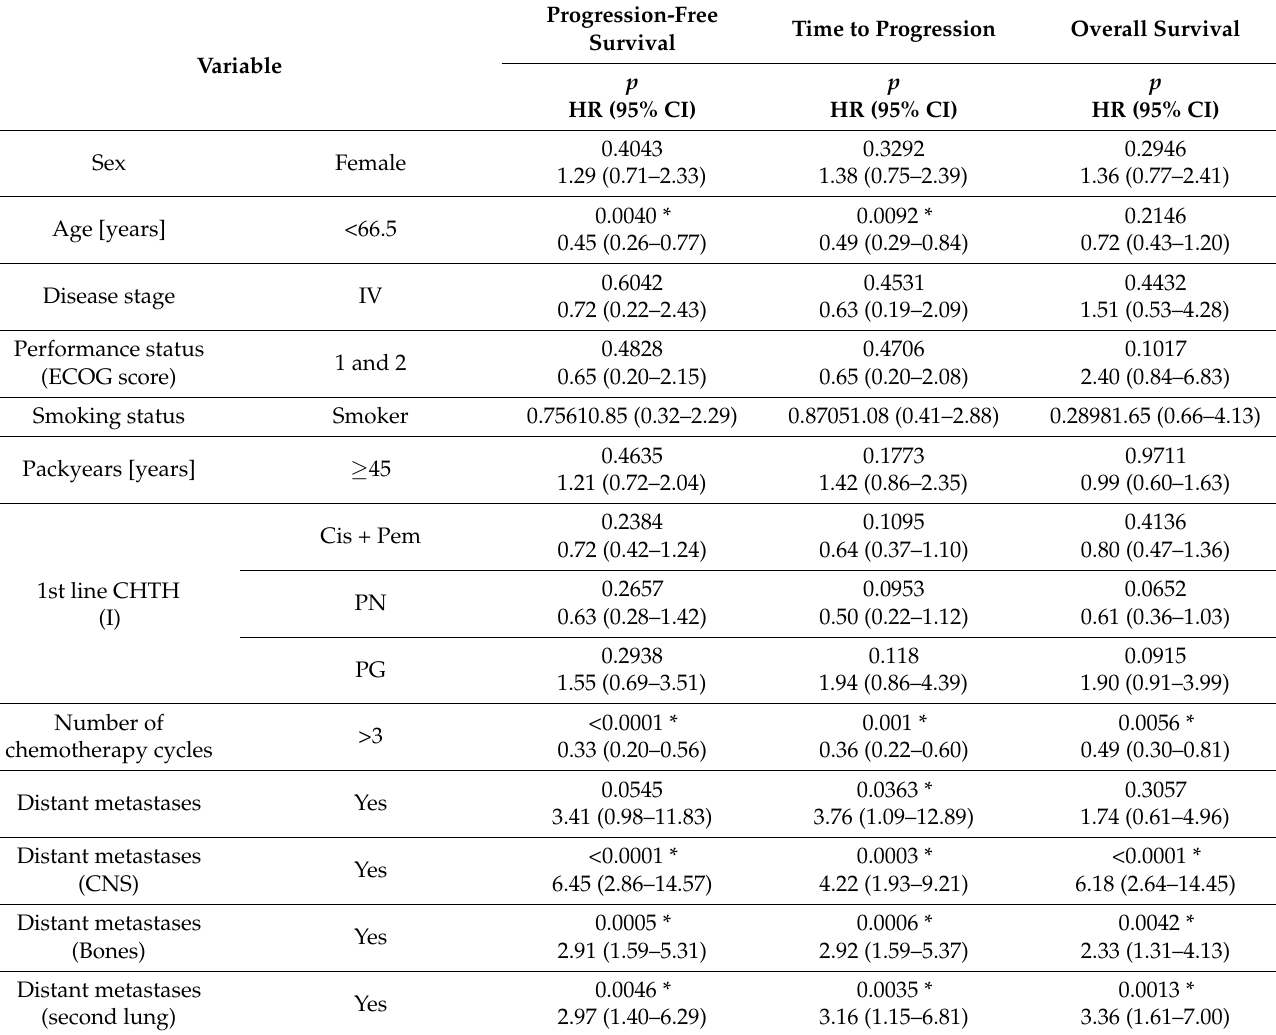
Table 4. Cox’s logistic regression analysis for progression-free survival, time to progression,